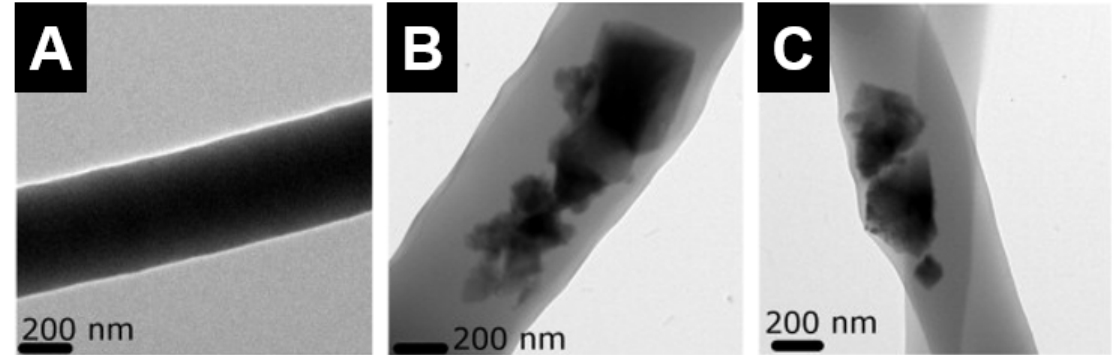
Figure 8. Transmission electron microscope images of electrospun nanofibres of ( A ) polycaprolactone (PCL); ( B ) PCL-hydroxyapatite (containing 40 wt % hydroxyapatite particles); and ( C ) PCL-hardystonite (containing 40 wt % hardystonite particles). The PCL-hardystonite nanofibres exhibited the highest tensile strength [122]. Adapted by permission of Elsevier, Copyright © 2013.